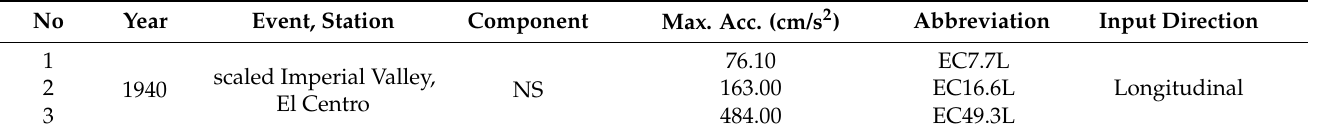
Figure 10. Time history acceleration of input motions. Table 3. Detail of input motion